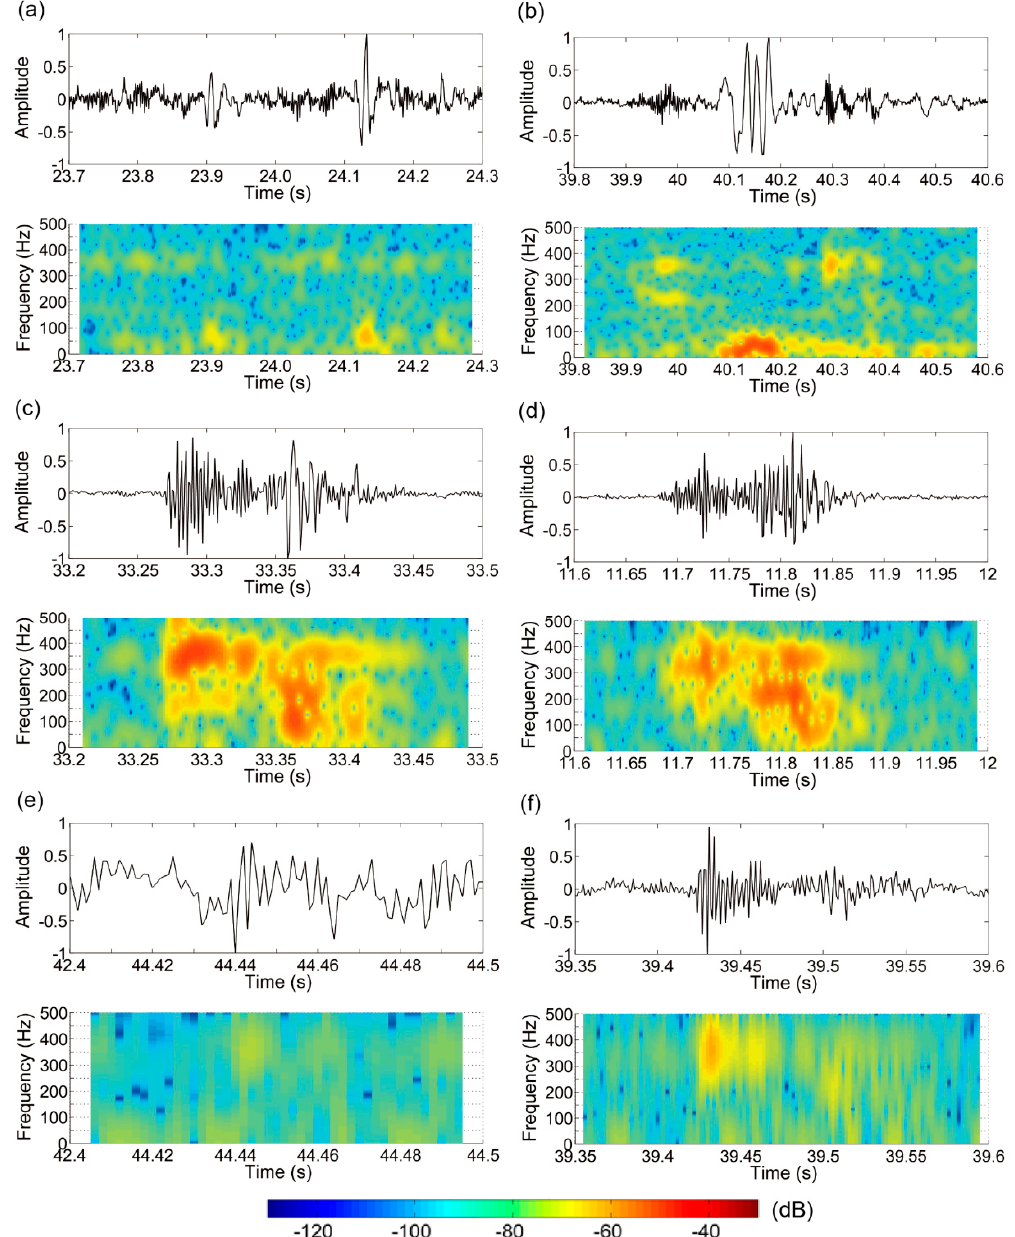
Figure 5. Spectrograms for the shallow ( a ), hybrid ( b ) and deep ( c – f ) icequakes from the seismometer No. 7. The origin times of the seismograms are the same as Figure 3.